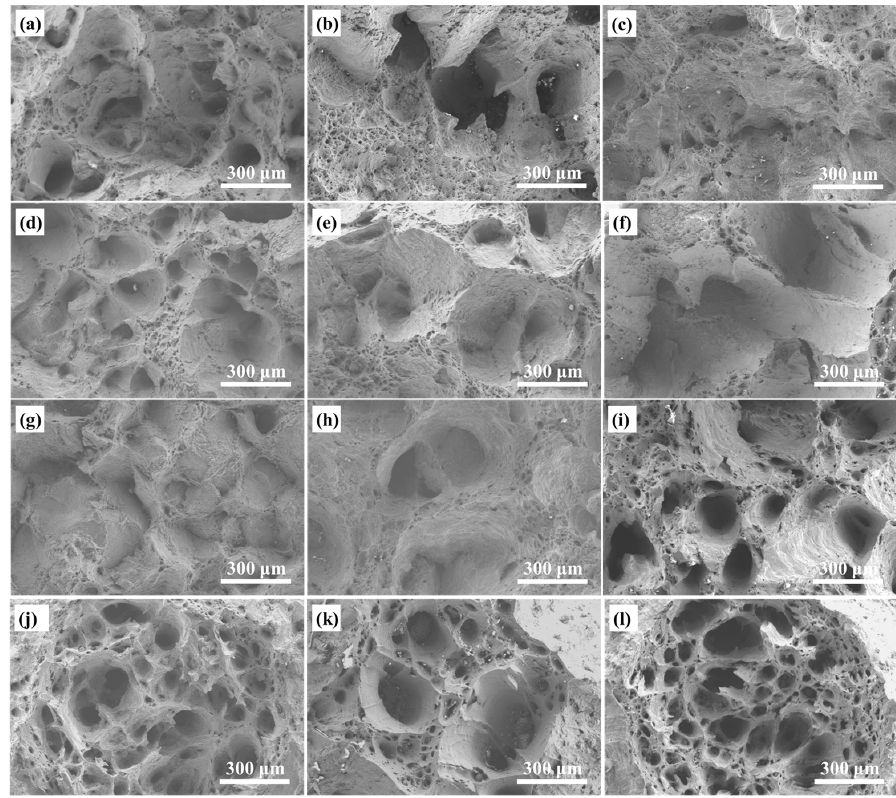
Figure 2. SEM fractographs of the specimens tested at different temperatures: ( a ) unadded steel at 750 ◦ C; ( b ) P-added steel at 750 ◦ C; ( c ) P + Ce-added steel at 750 ◦ C; ( d ) unadded steel at 800 ◦ C; ( e )